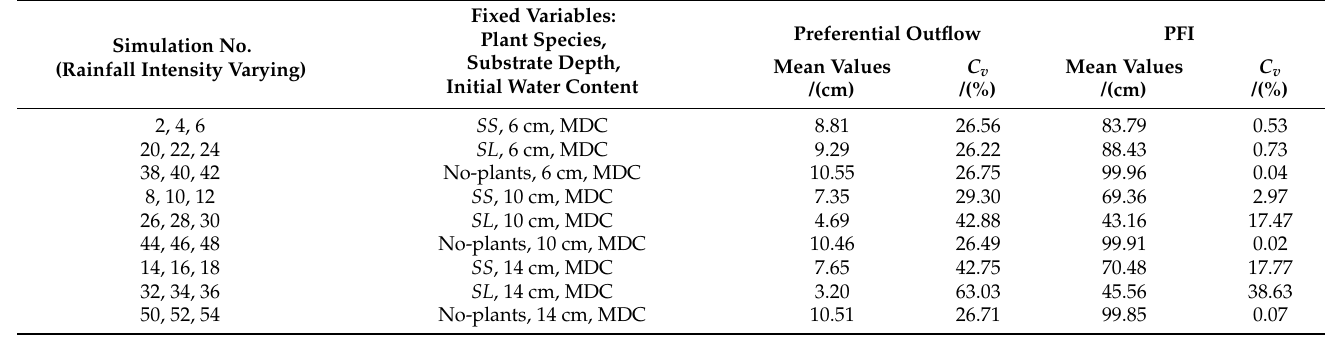
Table 8. Mean values and C v of PAS preferential outflow and PFI for different rainfall intensities.